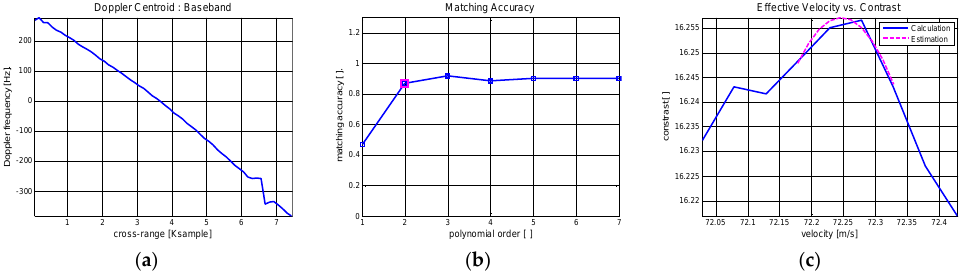
Figure 16. Doppler history estimation of Cessna 208 ISAR data: ( a ) ACCC based Doppler history estimation results; ( b ) Motion index estimation; ( c ) Effective velocity estimation. The range errors are measured from the estimated Doppler history through polynomial fitting.